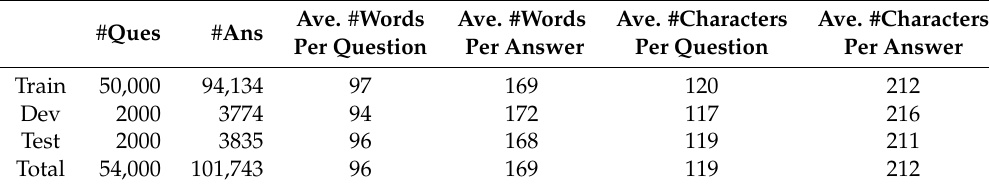
Table 2. Statistics of the cMedQA